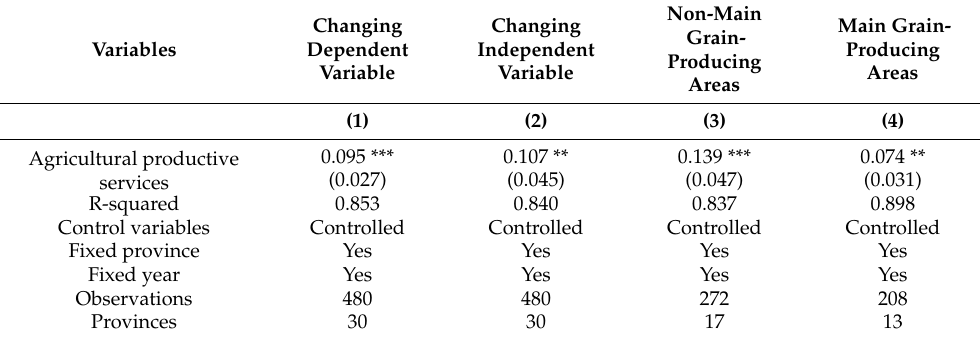
Table 4. Results of robust